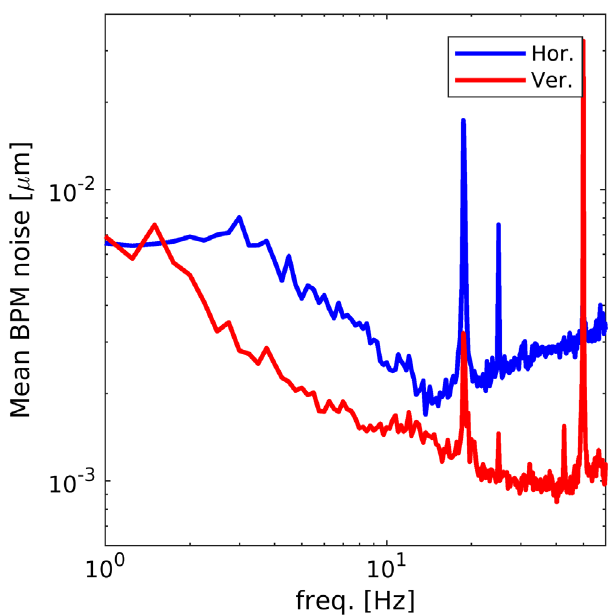
FIG. 9. Example of the 120 BPMs mean spectral noise at 18 mA (the typical beam current for a BBA measurement at ALBA). The noise decreases rapidly from zero to 15 Hz. It is worthwhile stressing the fact that while the BBA is influenced by the integrated noise spectrum ( 1 . 5 μ m and 0 . 8 μ m rms in the two planes, including the 50 Hz peak), the novel FBBA is affected only by the noise at the selected frequencies (which is below 10 − 2 μ m).